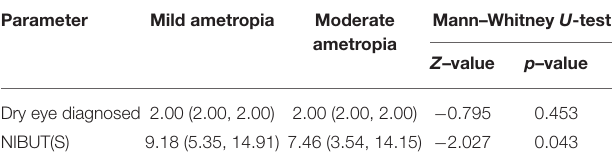
TABLE 5 | Effects of ametropia on tear film rupture time and dry eye incidence in